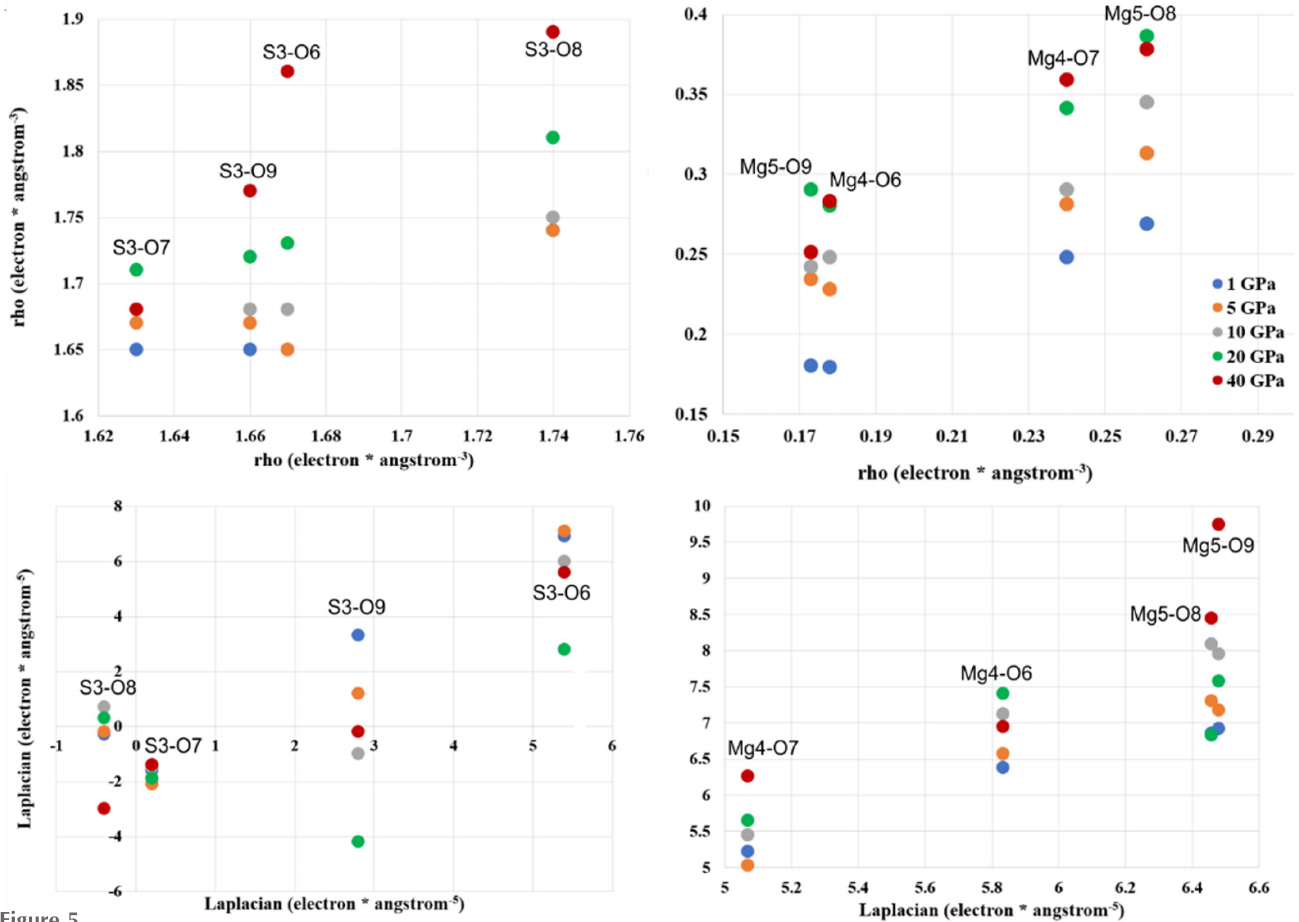
Figure 5 Laplacian and (cid:4) as a function of pressure for S—O and Mg—O contacts at the (3, (cid:4) 1) BCPs for theoretical